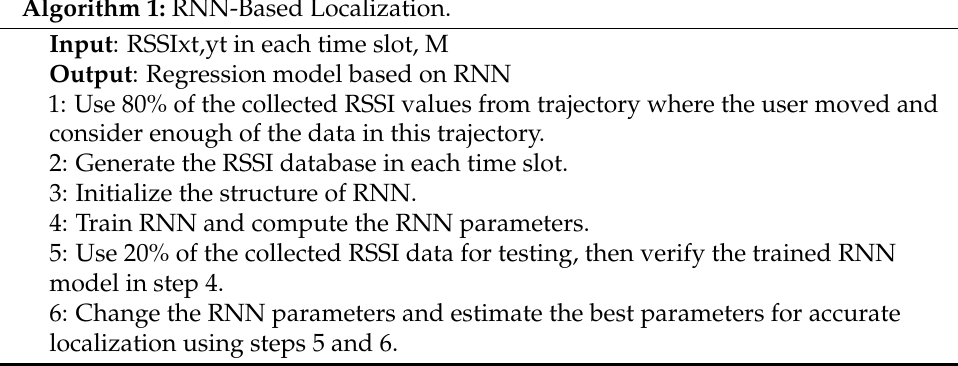
Algorithm 1: RNN-Based Localization.